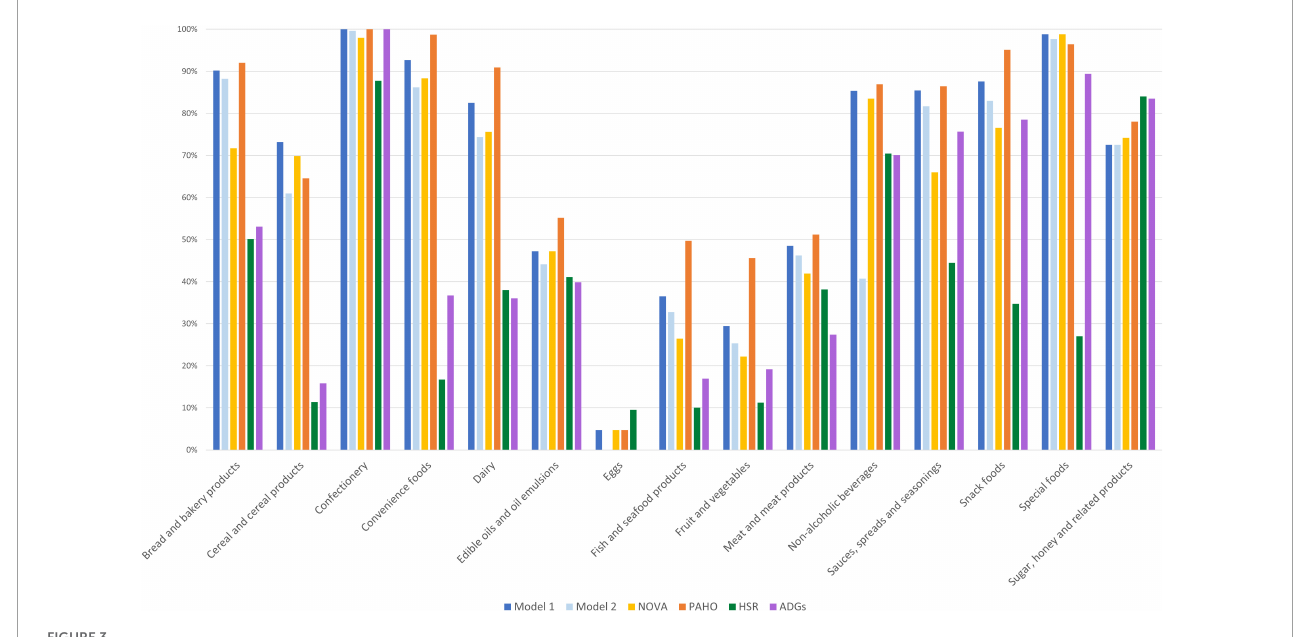
FIGURE3 Proportion of products classified as unhealthy by category and nutrition classification schemes [Model 1, Model 2, NOVA, the Pan American Health Organization’s Nutrient Profile Model (PAHO), the Health Star Rating (HSR), and the Australian Dietary Guidelines (ADGs)].